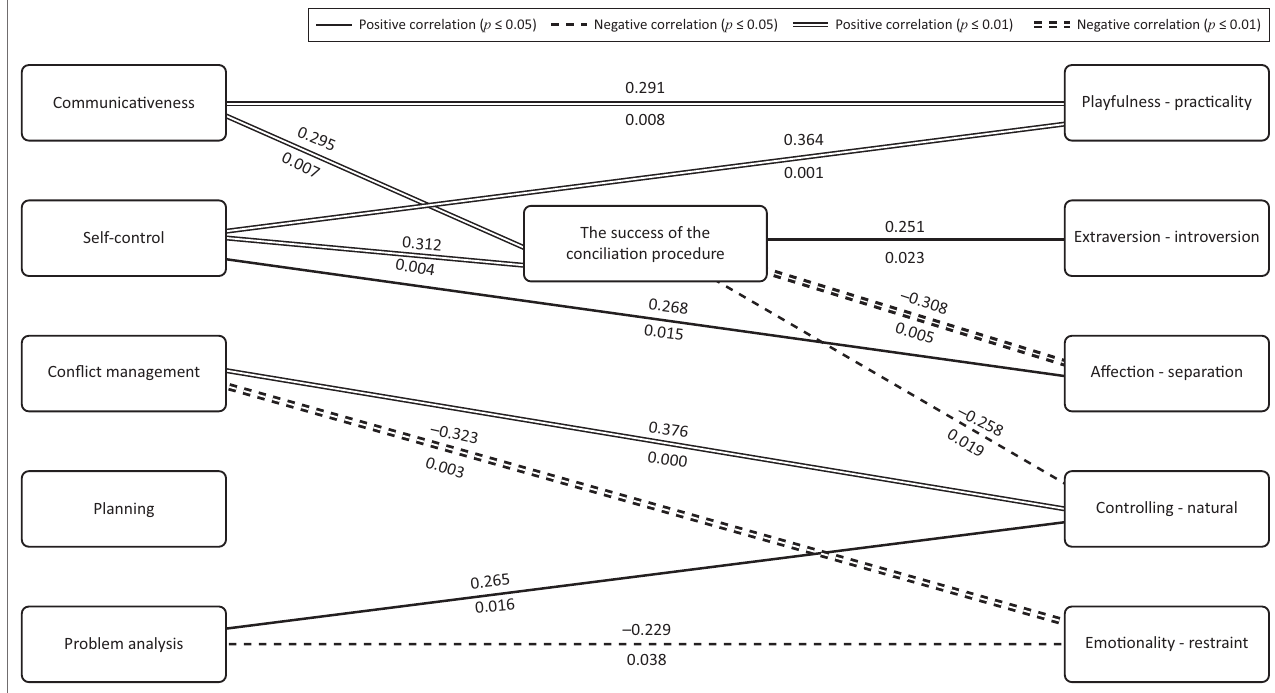
FIGURE 3: The relationship of professional competencies with the mediator’s internal rules and an objective criterion for the success of the conciliation procedure.